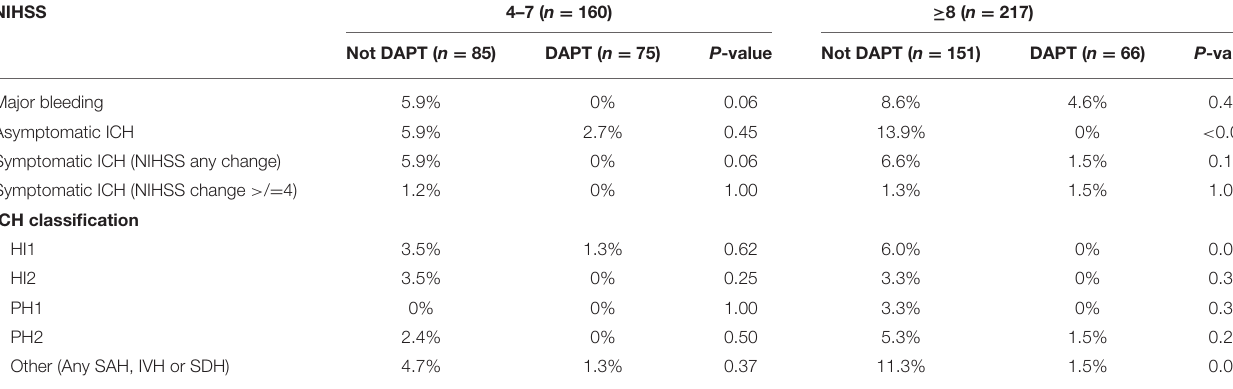
TABLE 3 | Bleeding rates among lower vs. higher NIHSS groups subcategorized by antiplatelet therapy groups.